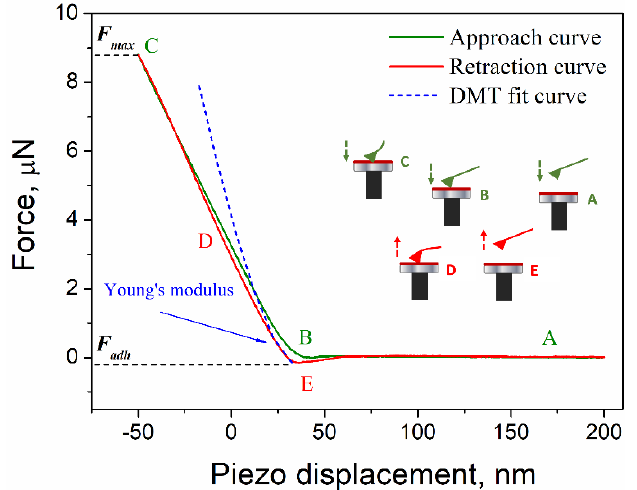
Figure 1. A typical force–distance curve measured on PEN during approach (green line) and retract (red line) of AFM probe to and from the sample surface.